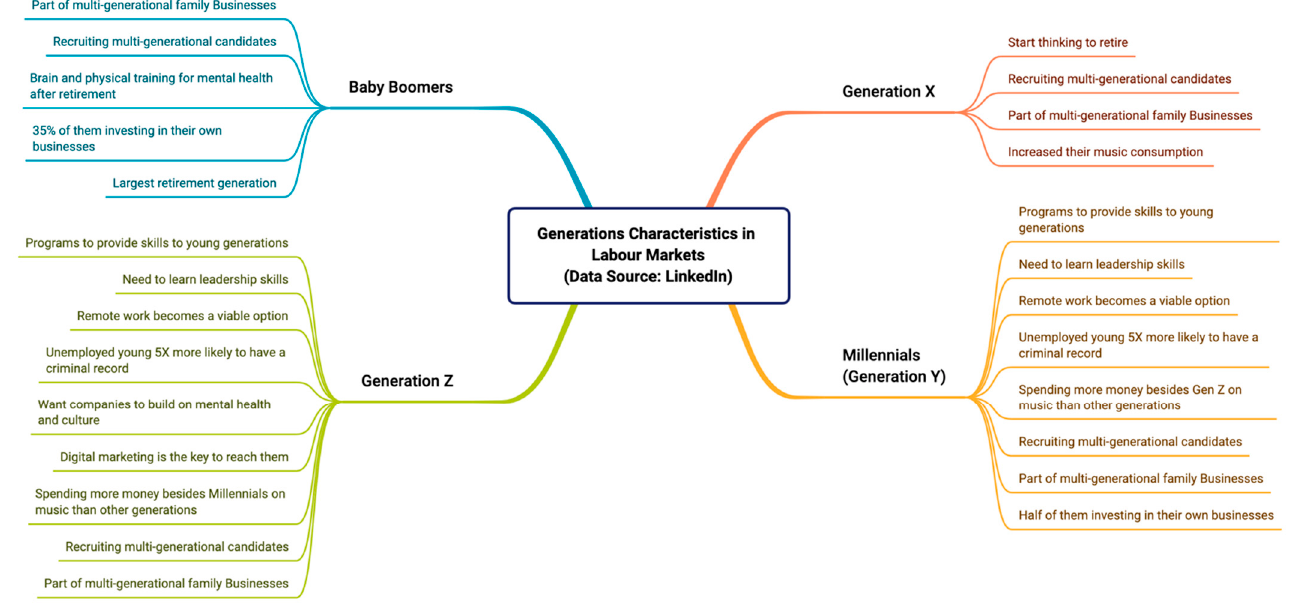
Figure 7. Different Generations in Labour Markets and Their Characteristics.